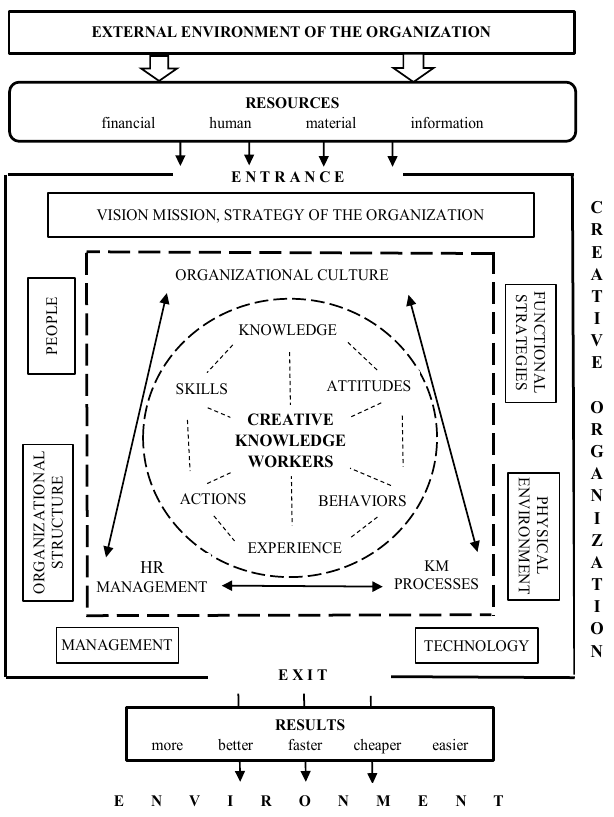
Figure 2. Knowledge worker in the creative organization. Source: created by the authors.